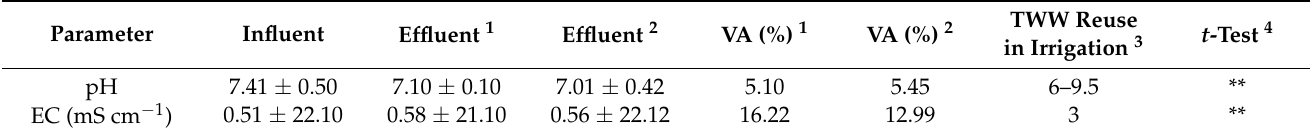
Table 1. Variation (VA) of pH and electrical conductivity (EC) in the two HSSFs CW units from March to October 2014/2018. For each unit, five-year average values ( ± standard deviation) are shown ( n = 80). Parameter